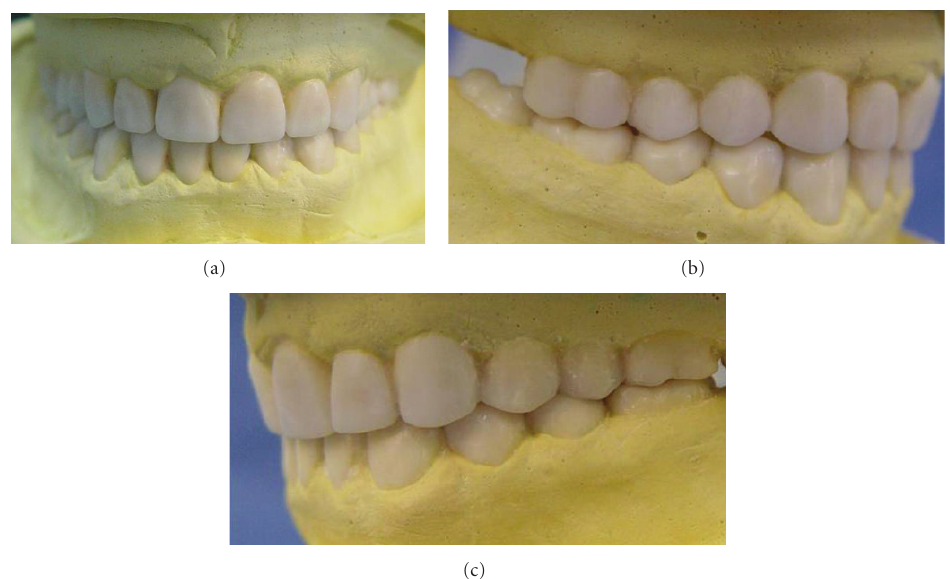
Figure 4: Diagnostic wax-up on diagnostic casts. (a) Frontal view; (b) right lateral view; (c) left lateral view.